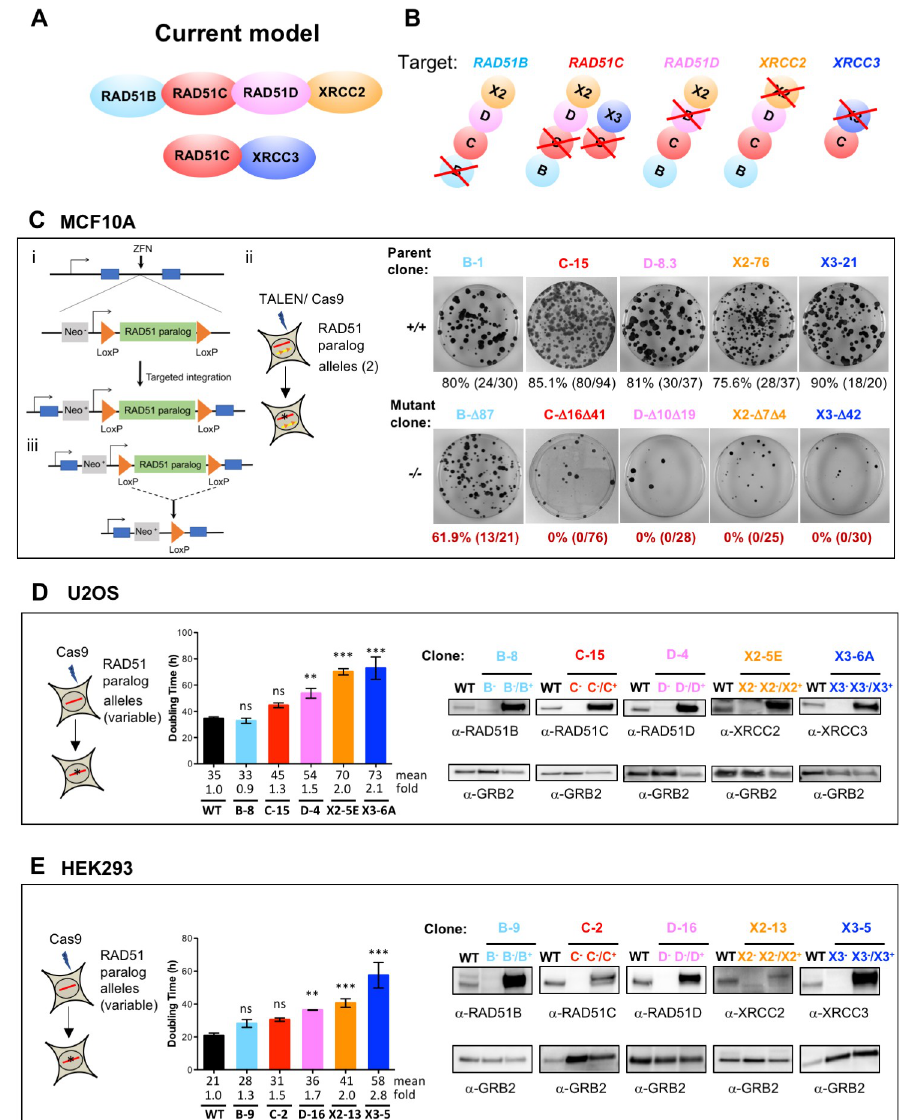
Fig 1. Individual disruption of the classical RAD51 paralogs in human MCF10A, U2OS, and HEK293 cells reveals variable effects on cell viability. (A) According to the current model based on biochemical studies, RAD51 paralogs exist in two different complexes where RAD51C is a common member of both. (B) Schematics showing the individual RAD51 paralog knockout. (C) i , RAD51 paralog cDNA flanked by LoxP sites was first targeted into the AAVS1 locus using zinc finger nucleases in MCF10A cells and the correct integration was selected as it results in expression of the promoterless Neo gene (these cells are designated as parental conditional). ii, nuclease-mediated gene editing was used on these parental conditional cells to mutate the endogenous RAD51 paralog alleles. iii, isogenic parental and conditional mutant RAD51 paralog cells were infected with lenti-Cre to delete the RAD51 paralog cDNA, two days post Cre infection cells were diluted for colony formation and analysis. Right panels shows examples of the Giemsa stained plates from the various isogenic parental (+/+) and knockout (-/-) cell lines after Cre treatment and underneath shows the number and % Cre excised clones for each. The conditional parental and mutant RAD51 paralog clones that were used in this study are listed on top of each plate. (D, E) CRISPR/Cas9 mediated gene editing was used on U2OS and HEK293 cells to delete the RAD51 paralog endogenous alleles. Graphs show doubling time for the wild-type and the mutant RAD51 paralog cells. Number of viable cells was estimated using the CellTiter-Glo Luminescent Cell Viability Assay at 24 h, 48 h, 72 h and 96 h after seeding. Cell doubling time was calculated by nonlinear regression (exponential growth equation). Results are presented as means +/- SD from three experiments. Differences between mutant and wild-type cells were statistically analyzed using unpaired one-way ANOVA and Tukey’s test. �� p < 0.01, ��� p < 0.001, ns not significant. Immunoblots of crude cellular extracts from wild-type cells, mutant cells and mutant cells stably complemented with a retroviral construct expressing the corresponding